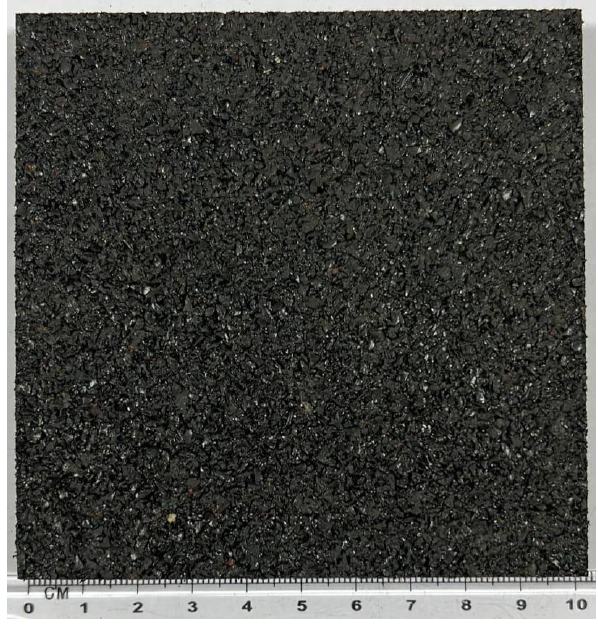
Figure 4. Recycled rubber tile.